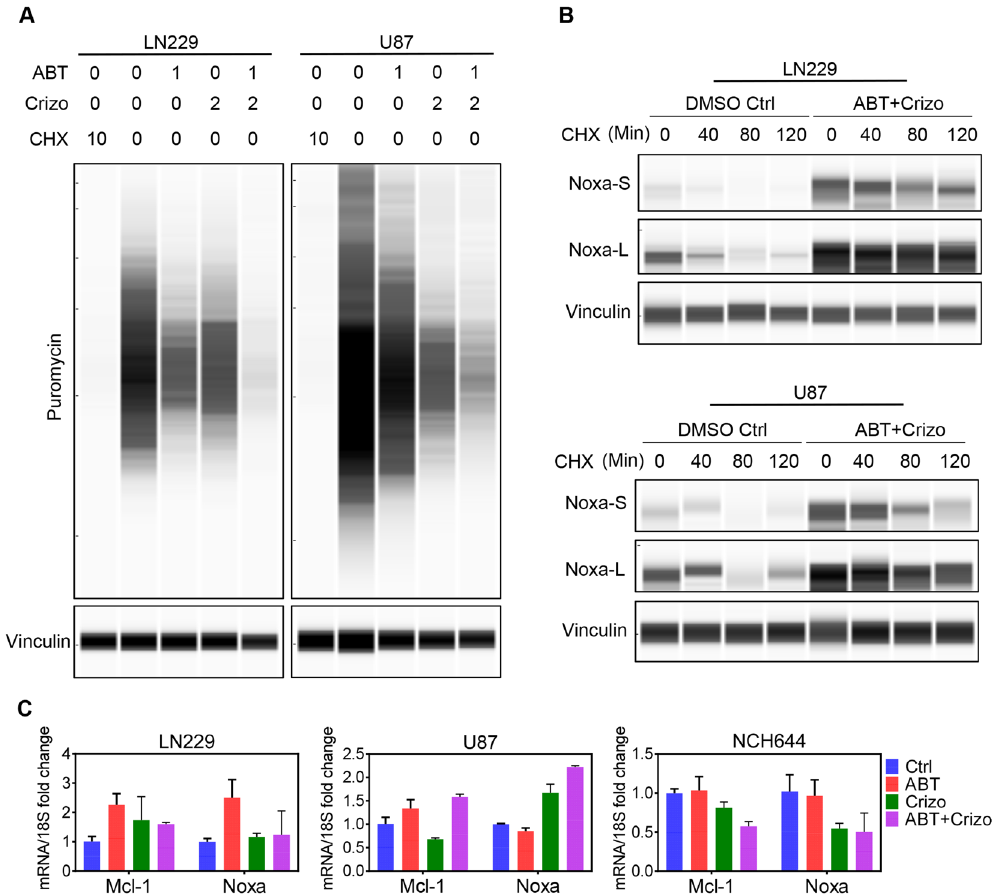
Figure 5. C-MET and Bcl-2/Bcl-xL inhibition suppresses protein synthesis and stabilize pro-apoptotic Noxa. ( A ) LN229 and U87 GBM cells were treated with ABT263, Crizotinib or the combination of both (24 h) (concentrations in μ M). At the end of the treatment period, cells were incubated for 2 h with puromycin. Thereafter, whole cell protein lysates were harvested and analyzed by capillary electrophoresis for the expression of puromycin (protein synthesis activity in cancer cells after various treatments referred to as SUNSET assay). Cycloheximide (CHX) serves as a positive control (concentrations are in μ g/ml) ABT: ABT263, Criz: Crizotinib. ( B) LN229 or U87 GBM cells were exposed to cycloheximide in the presence or absence of the combination treatment of ABT263 and Crizotinib. Thereafter, whole protein lysates were isolated and analyzed by capillary electrophoresis. ABT + Crizo: ABT263 1 μ M + Crizotinib 2 μ M. Noxa-S and Noxa-L refer to the exposure times. L: long exposure; S:short exposure. ( C ) LN229, U87 and stem like GBM cells, NCH644, were treated as indicated for 24 h. RT-PCR was performed for the expression of Mcl-1 and Noxa. Ctrl: Control, ABT: 1 μ M ABT263, Crizo: 2 μ M